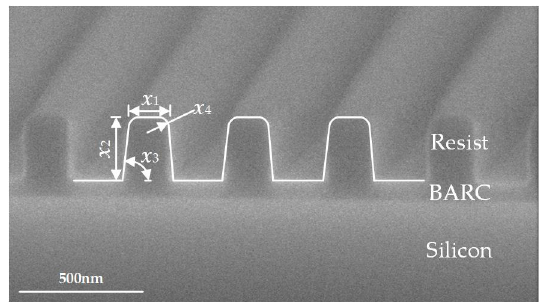
Figure 4. SEM micrograph and geometric model of the photoresist grating.